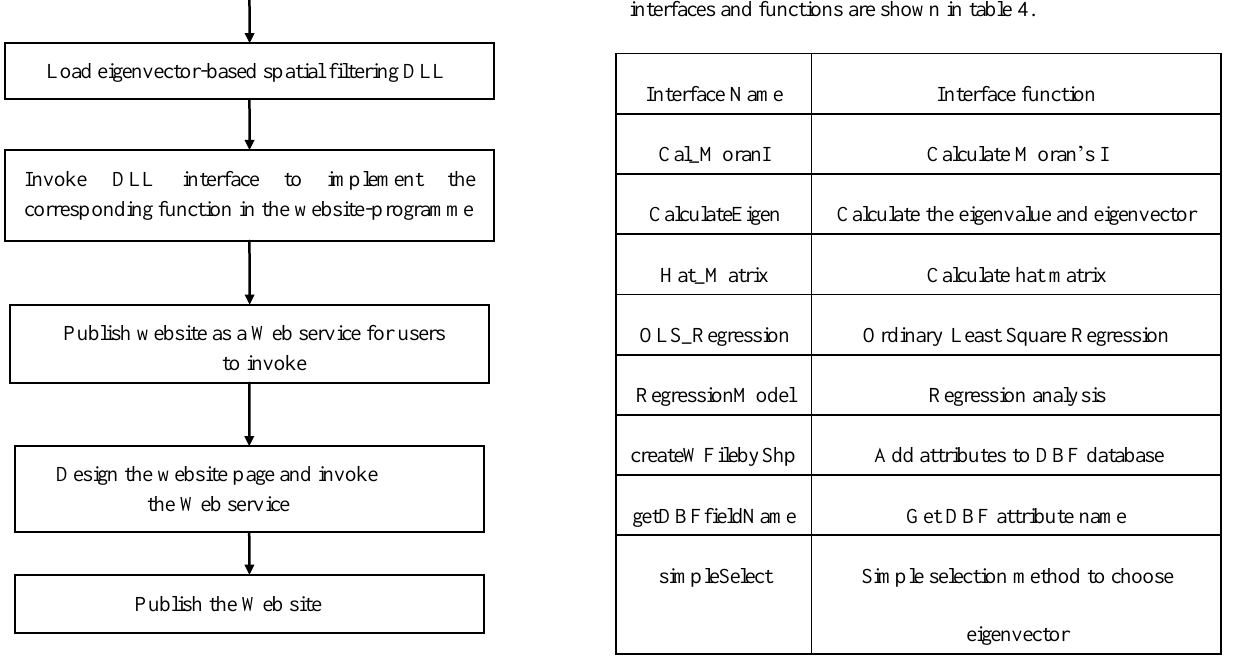
Figure 2.Web service process